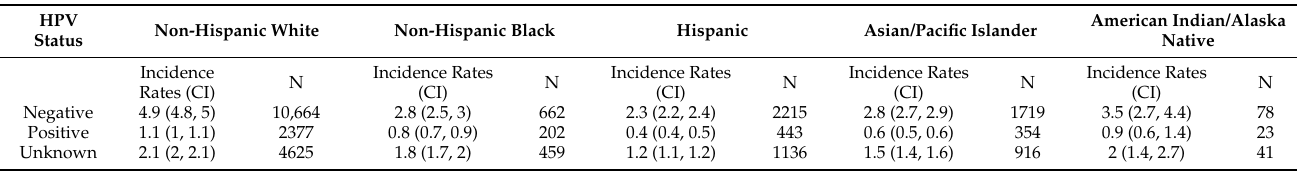
1 Rates are per 100,000 and age-adjusted to the 2000 US Std Population (19 age groups—Census P25-1130) standard; Confidence intervals (Tiwari mod) are 95% for rates. 2 HPV status was collected as defined by the CS Collaborative Stage Data Collecting System, version 02.05 schemas.